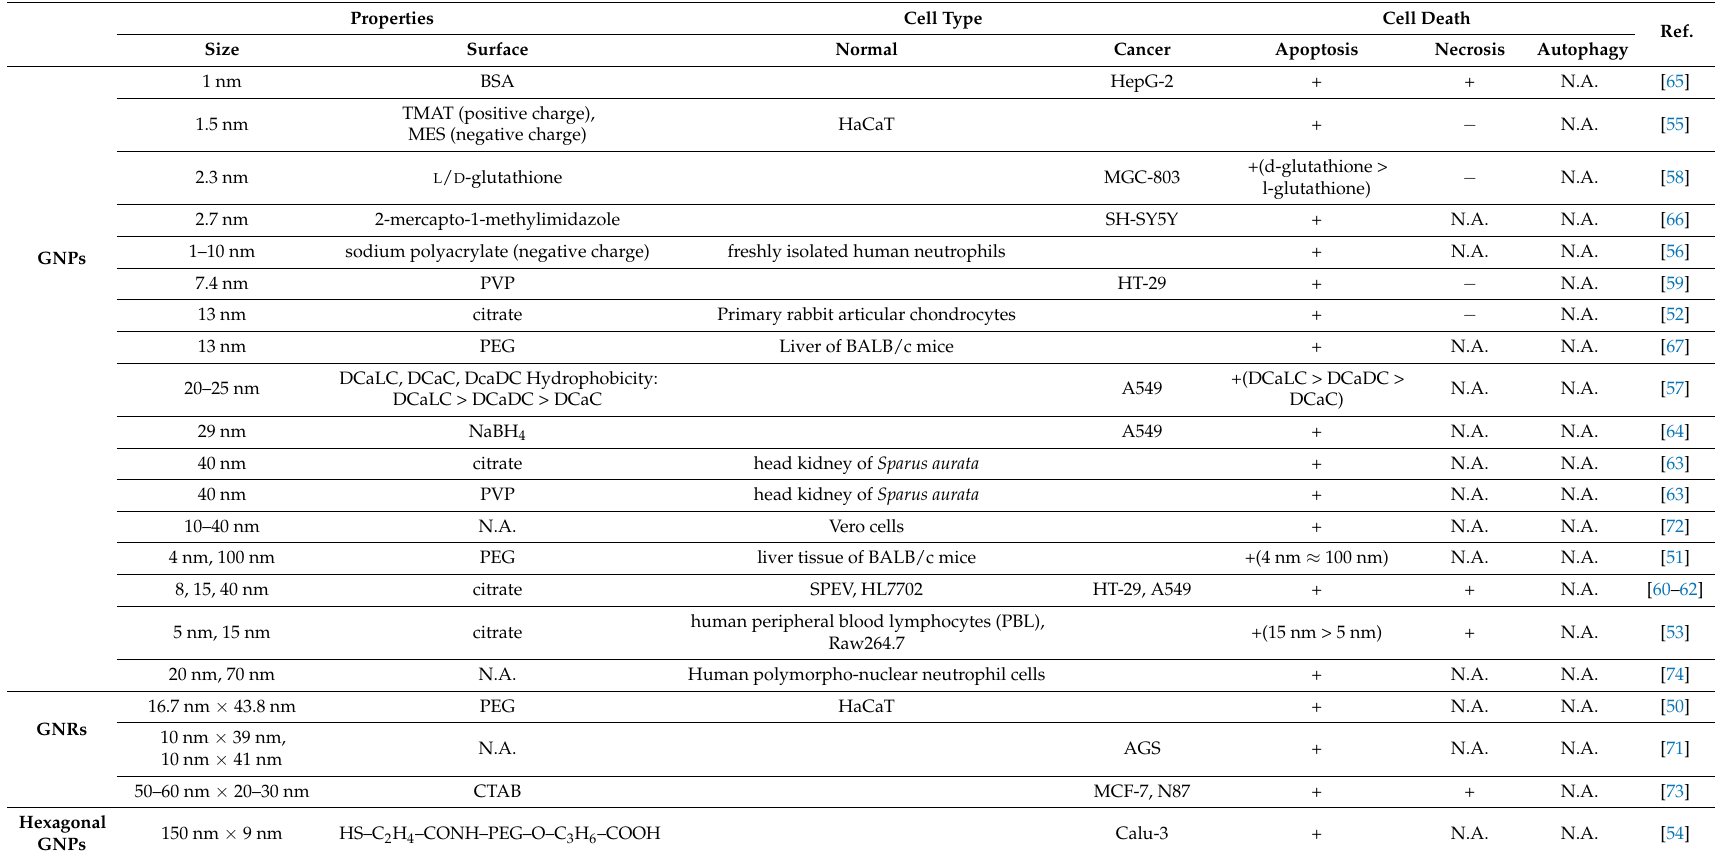
Table 1. The relationship between gold nanoparticles (GNPs)’ properties and